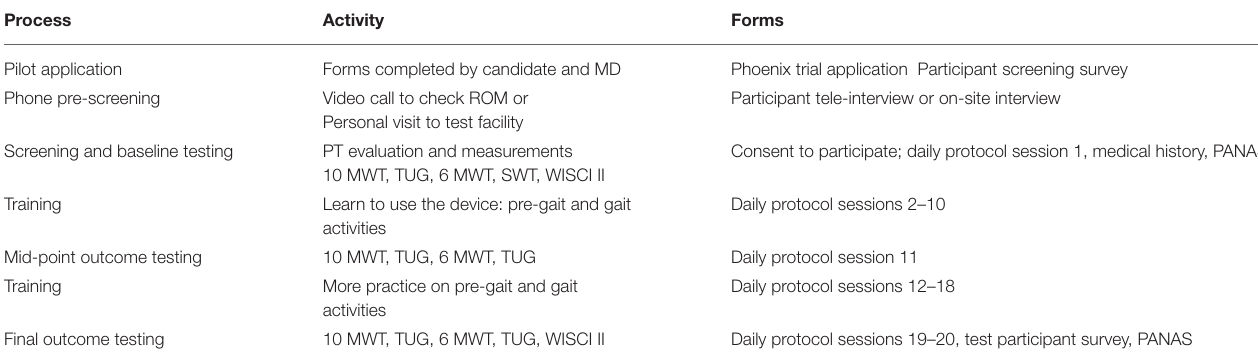
TABLE 3 | Outline of training and assessment protocol.